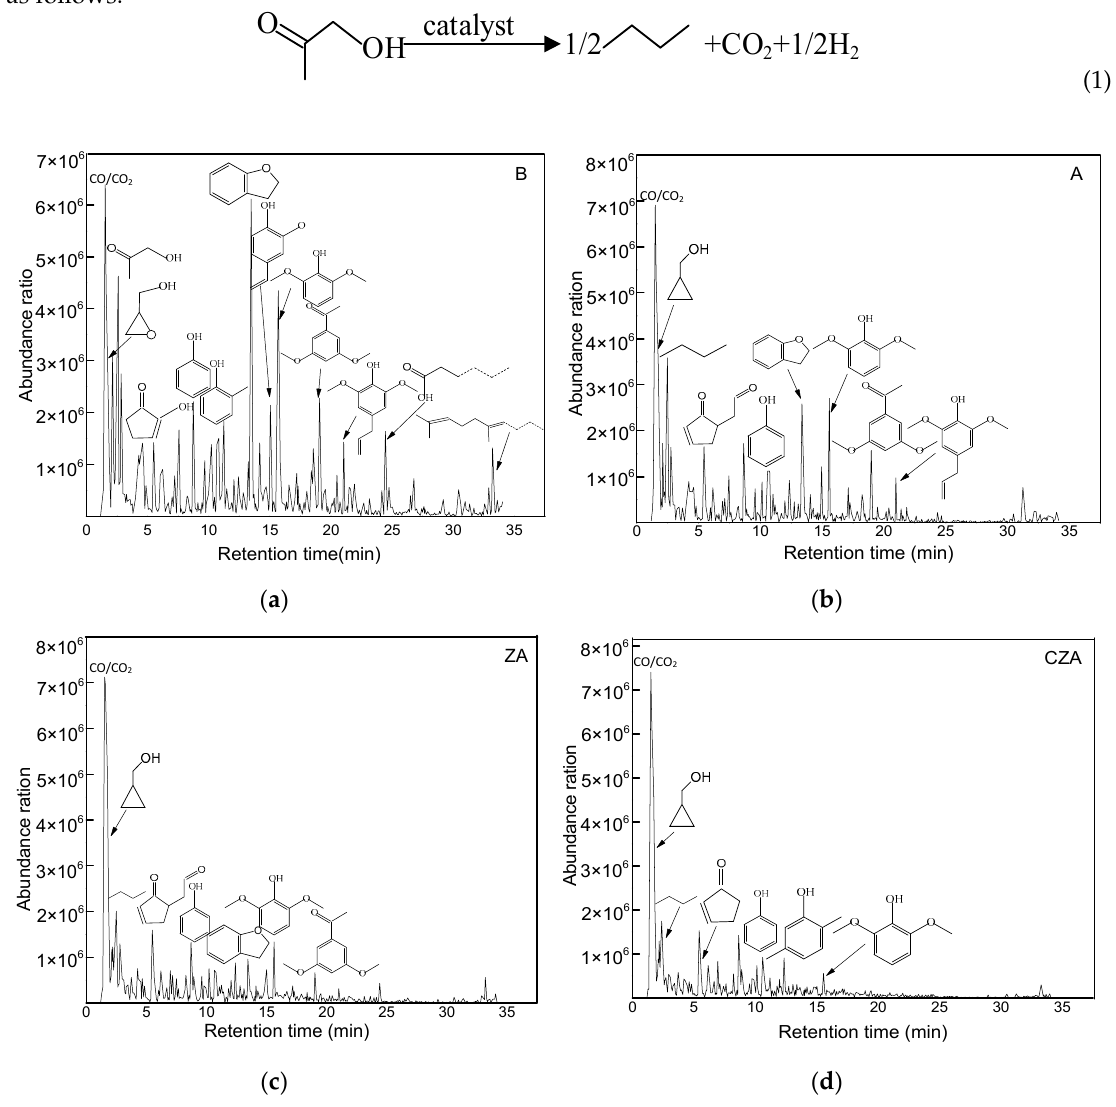
Figure 3. GC/MS Chromatogram of the pyrolysis products: ( a ) without catalyst, ( b ) with catalyst A, ( c ) with catalyst ZA, ( d ) with catalyst CZA.